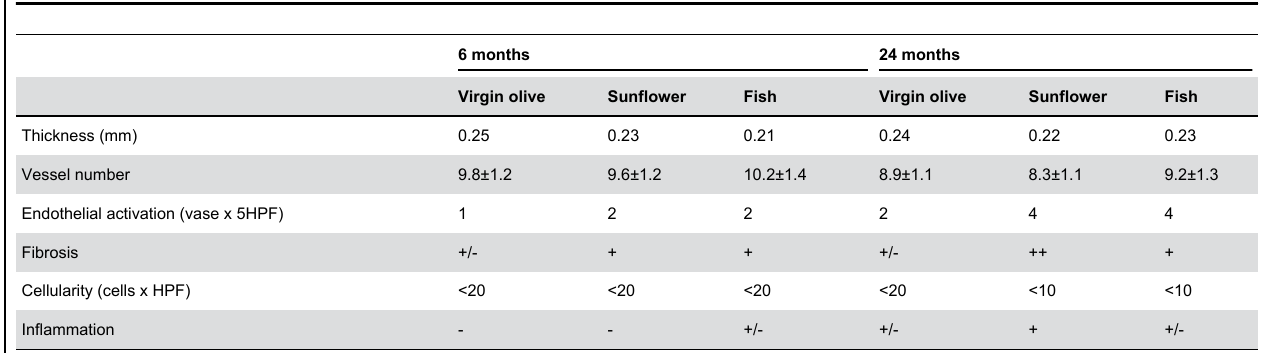
Table 3. Histological findings in rat tissue sections stained with haematoxylin and eosin.